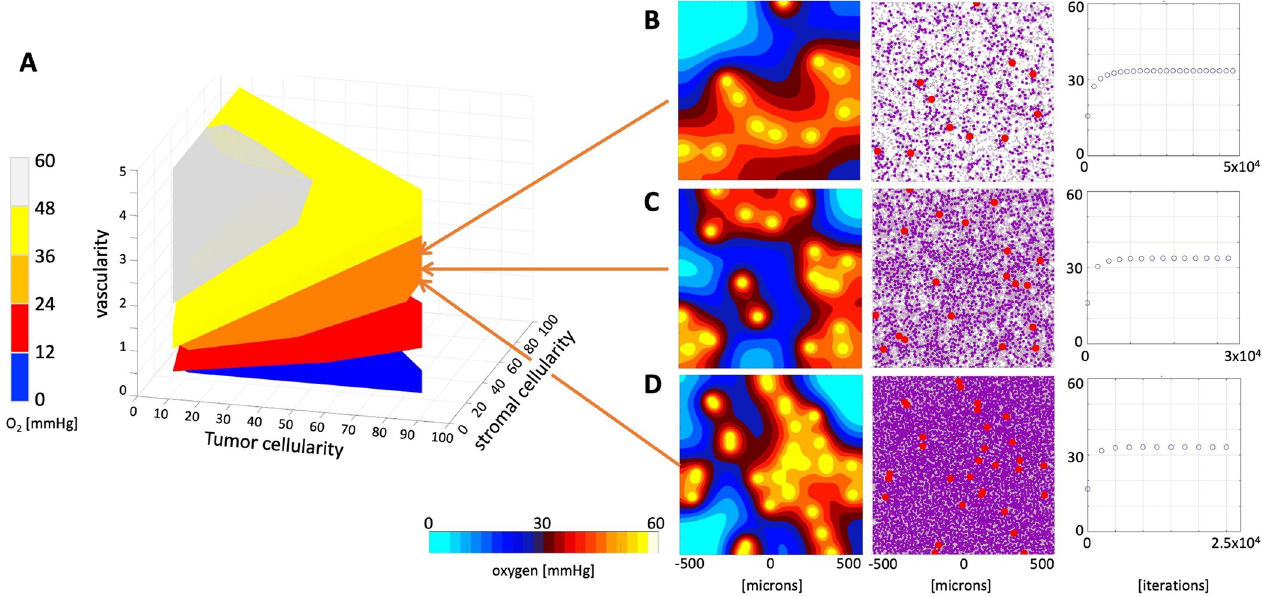
Fig 3. Classification of tissue oxygenation. A . A parameter space (convex hulls) of tissues characterized by vascularity, tumor cellularity and stromal cellularity classified into five classes with respect to the stabilized average oxygen level. For every tissue characteristic only one tissue morphology was included. B-D. Three examples of tissues with similar oxygen saturation levels: B. A tissue with vascularity 1.5%, tumor cellularity 15%, stromal cellularity 15%, and stable oxygen of 33.43 mmHg. C. A tissue with vascularity 2.5%, tumor cellularity 30%, stromal cellularity 35%, and stable oxygen of 33.53 mmHg. D. A tissue with vascularity 4%, tumor cellularity 75%, stromal cellularity 20%, and stable oxygen of 33.16 mmHg.